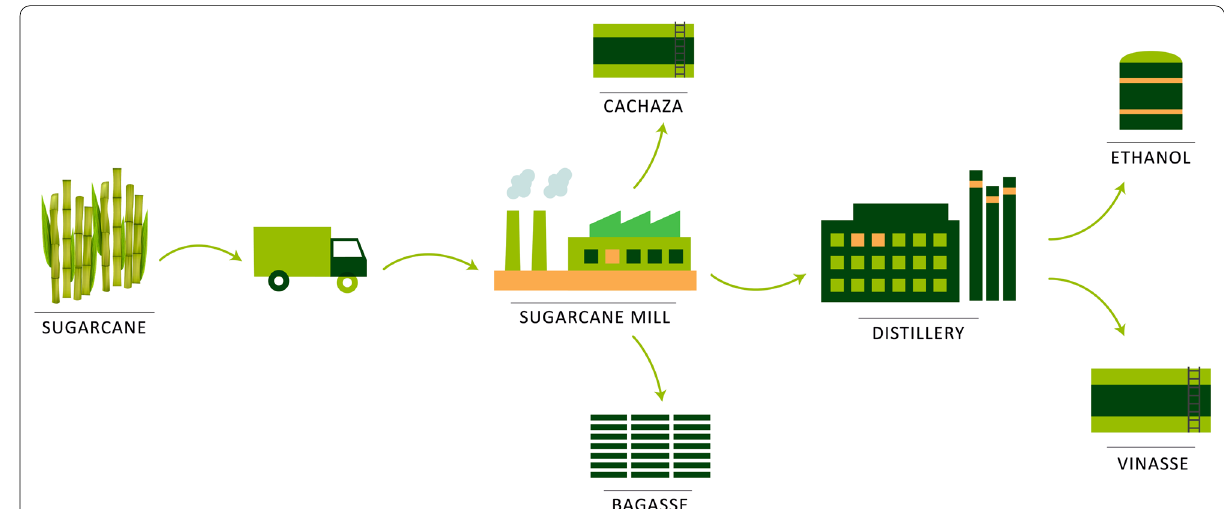
Fig. 1 Flowchart of bioethanol production